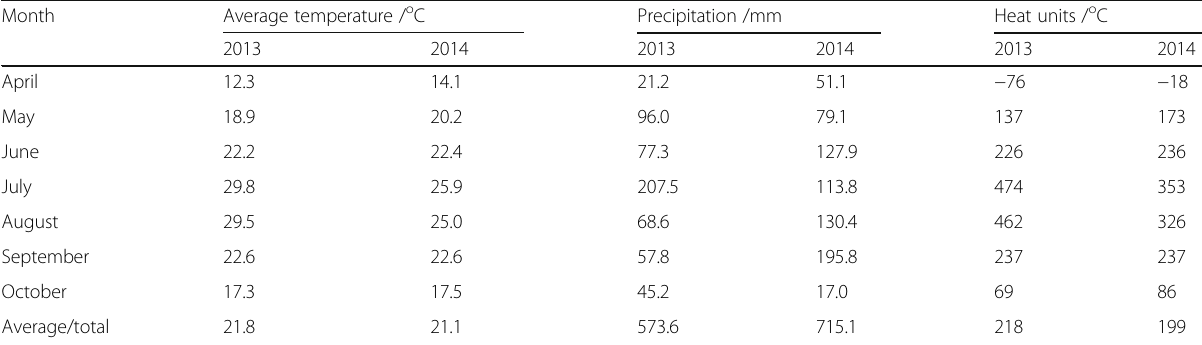
Table 5 Meteorological factors during the cotton growth period at the experimental station in Dafeng, Jiangsu Month Average temperature / o